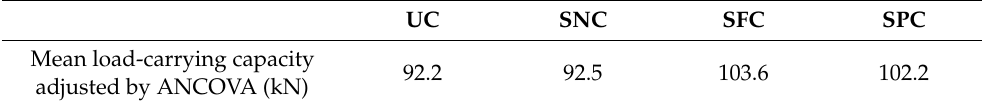
Table 6. Results of load-carrying capacity adjusted by ANCOVA.